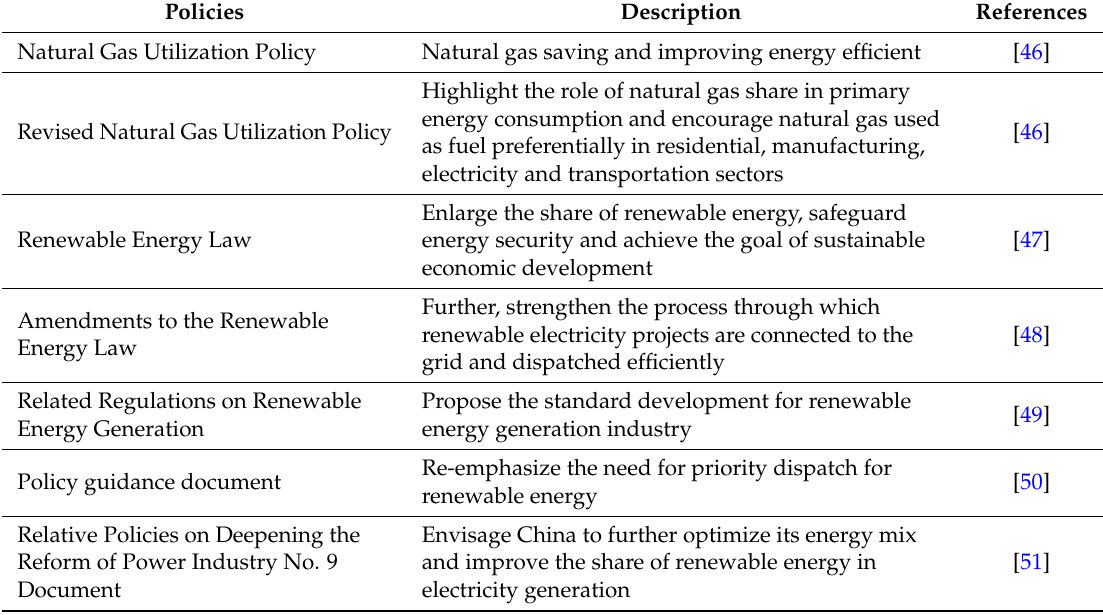
Table 3. Laws and regulations concerning cleaner energy use in the power sector.